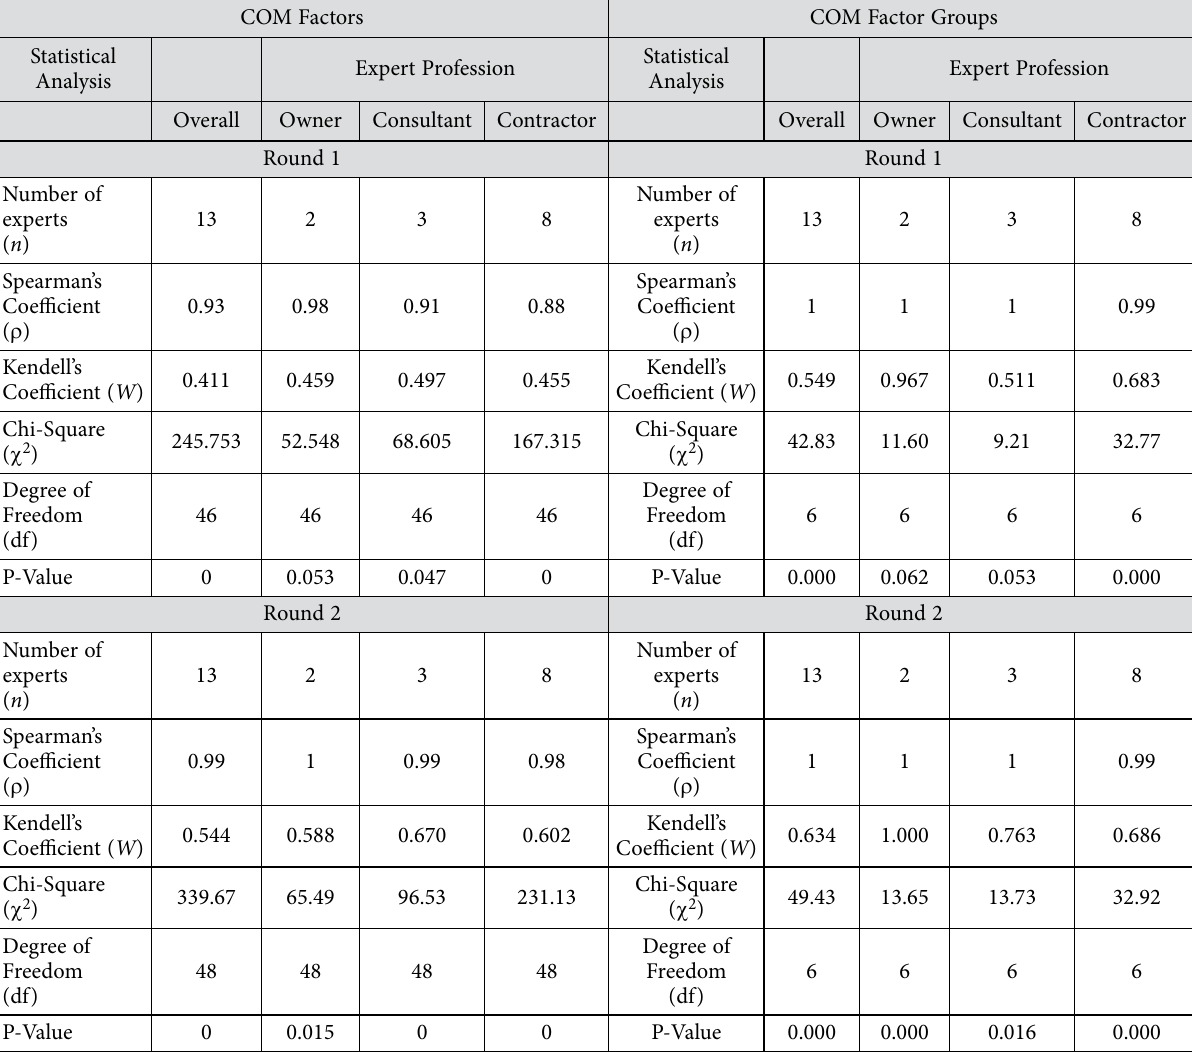
Table 6. Statistical test results for COM factors and groups – Rounds 1 and